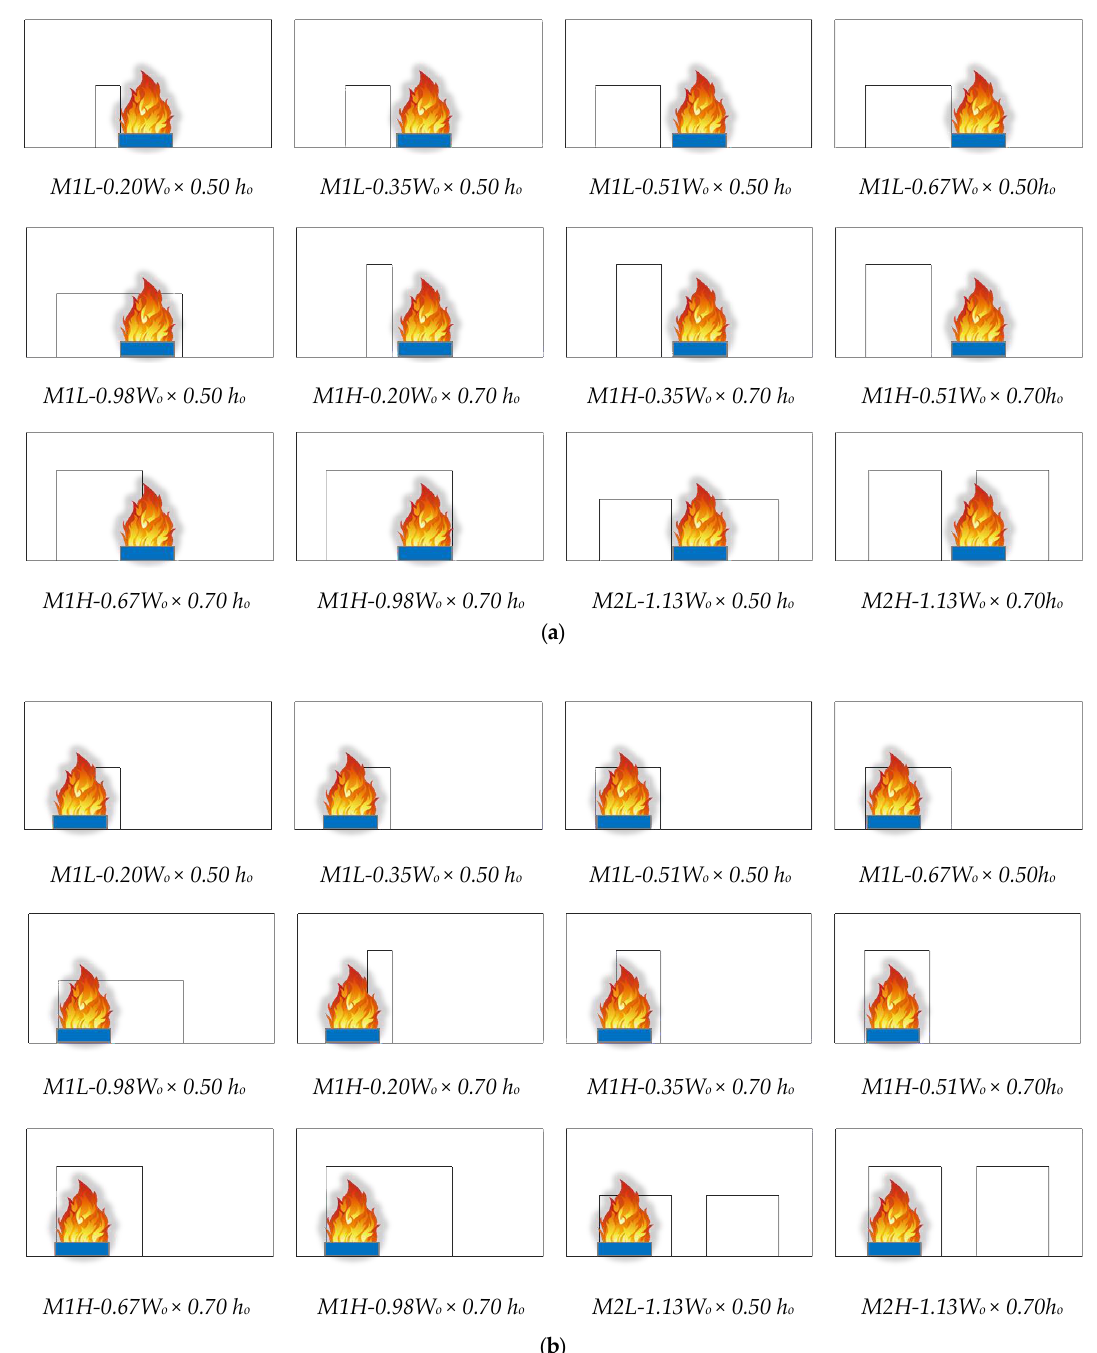
Figure 15. Configuration of fire sources and obstacles: ( a ) Pattern A; ( b ) Pattern B. (units: m).